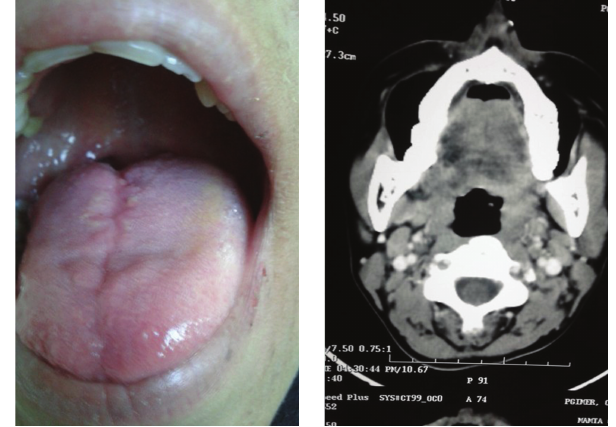
Figure 2: Intraoperative photograph showing midline glossotomy exposing the tumor in the base of tongue and removed specimen.